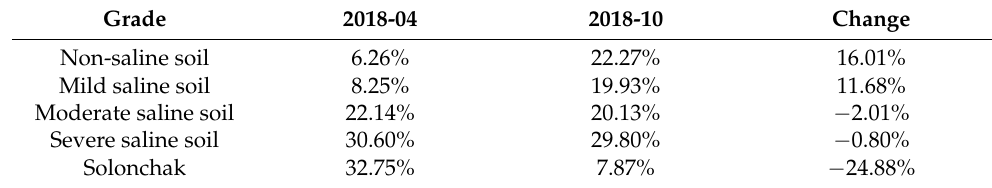
Table 4. Spatial-temporal variation of salinization in Kenli District, Yellow River Delta in